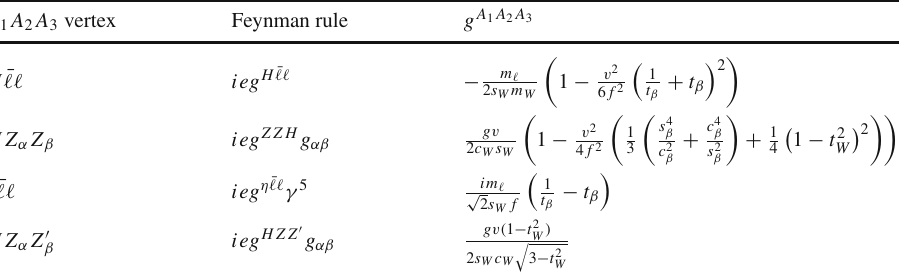
A 1 A 2 A 3 vertex